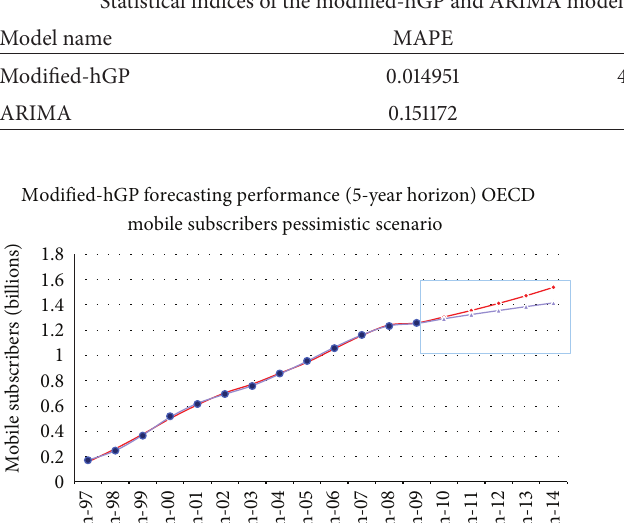
Table 14: Statistical indices in forecasting process of the modified-hGP and ARIMA model for the total number of OECD 3G mobile subscribers.